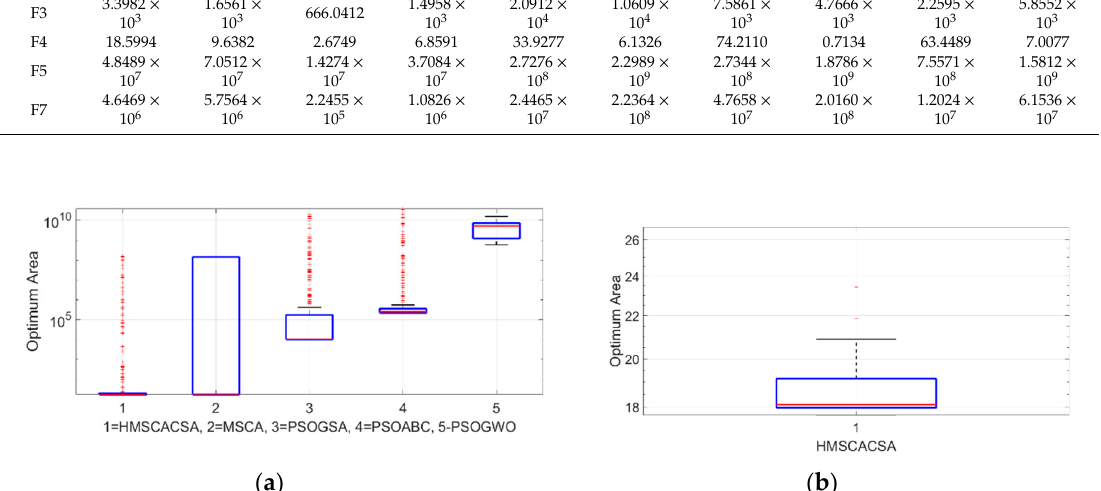
Table 4. Comparative statistical results for state-of-the-art algorithms using six benchmark functions for a population = 30, with 20 dimensions and a maximum of 1500 iterations. Table 3. Percentage differences between our proposed method (HMSCACSA) and other metaheuristics (MSCA, PSOGSA, PSOABC, and PSOGWO; results also presented in Figure 6).